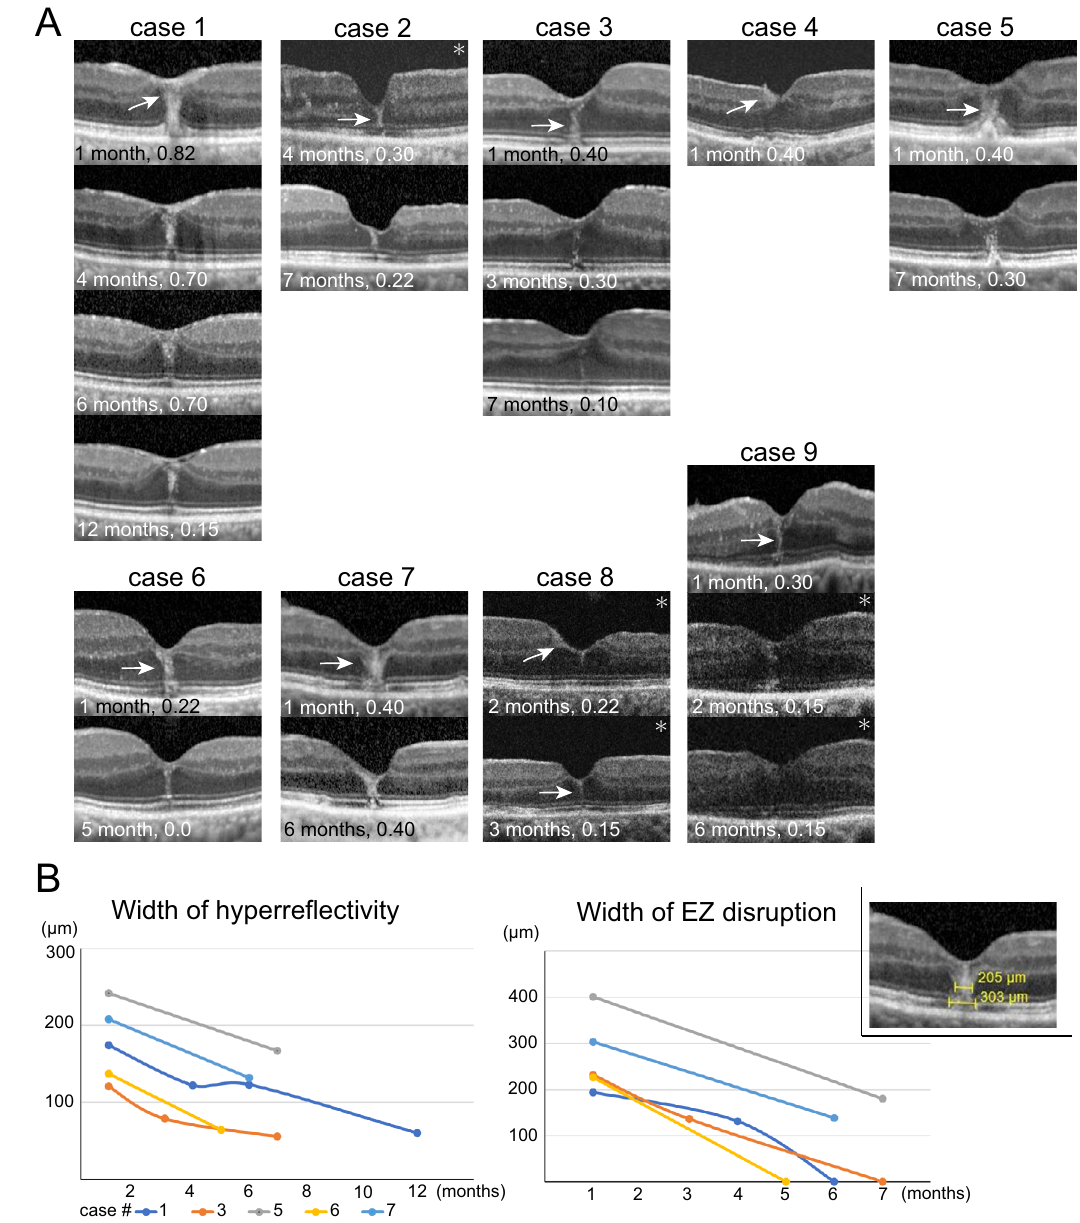
Figure 2. Postoperative SD-OCT images of the central macula. A majority of the images were taken using SPECTRALIS, and those marked with asterisk were obtained using 3D OCT-2000. ( A) A vertical hyperreflective signal at the central fovea (arrows) was observed in all eyes, except in case 4. EZ/IZ disruption was observed in all eyes, except cases 4 and 8. In each image, the postoperative months of the image acquisition and a logMAR BCVA value are described. ( B) Width of hyperreflectivity and EZ disruptions were measured in cases in which the SD-OCT images were taken using SPECTRALIS on two or more occasions postoperatively (cases 1, 3, 5, 6, and 7), showing the gradual fading of the OCT findings. Inset is the representative measurement of widths of hyperreflectivity and EZ disruption using a built-in caliper